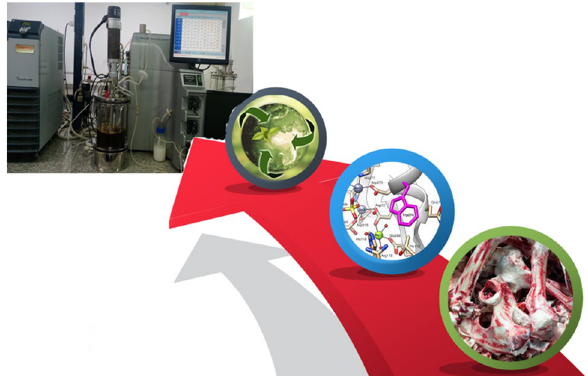
Figure 1. Schematic illustration of biogenic apatite waste utilization to scale up the production of bacterial ALP from the Bacillus paralicheniformis strain APSO to the bench-top bioreactor scale for green chemistry